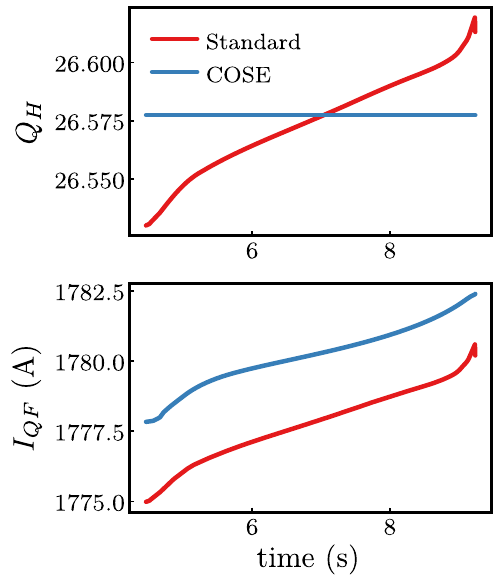
FIG. 9. Comparison of tune function on SPS flat-top for tune sweep and COSE slow extraction. The scaling with beam momentum is only visible on the current. The vertical offset in the quadrupole currents between COSE and quadrupole driven extraction corresponds to the tune difference Δ Q h ¼ 1 where δ p=p is the total initial momentum spread and Q 0 h is the